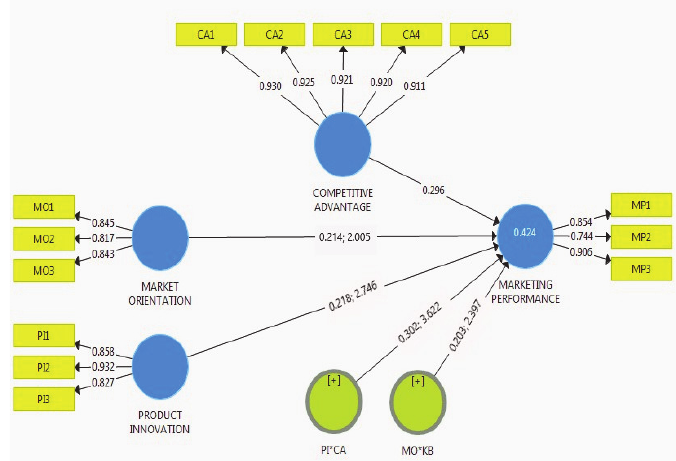
Fig. 2. Summary Figure of structural Model